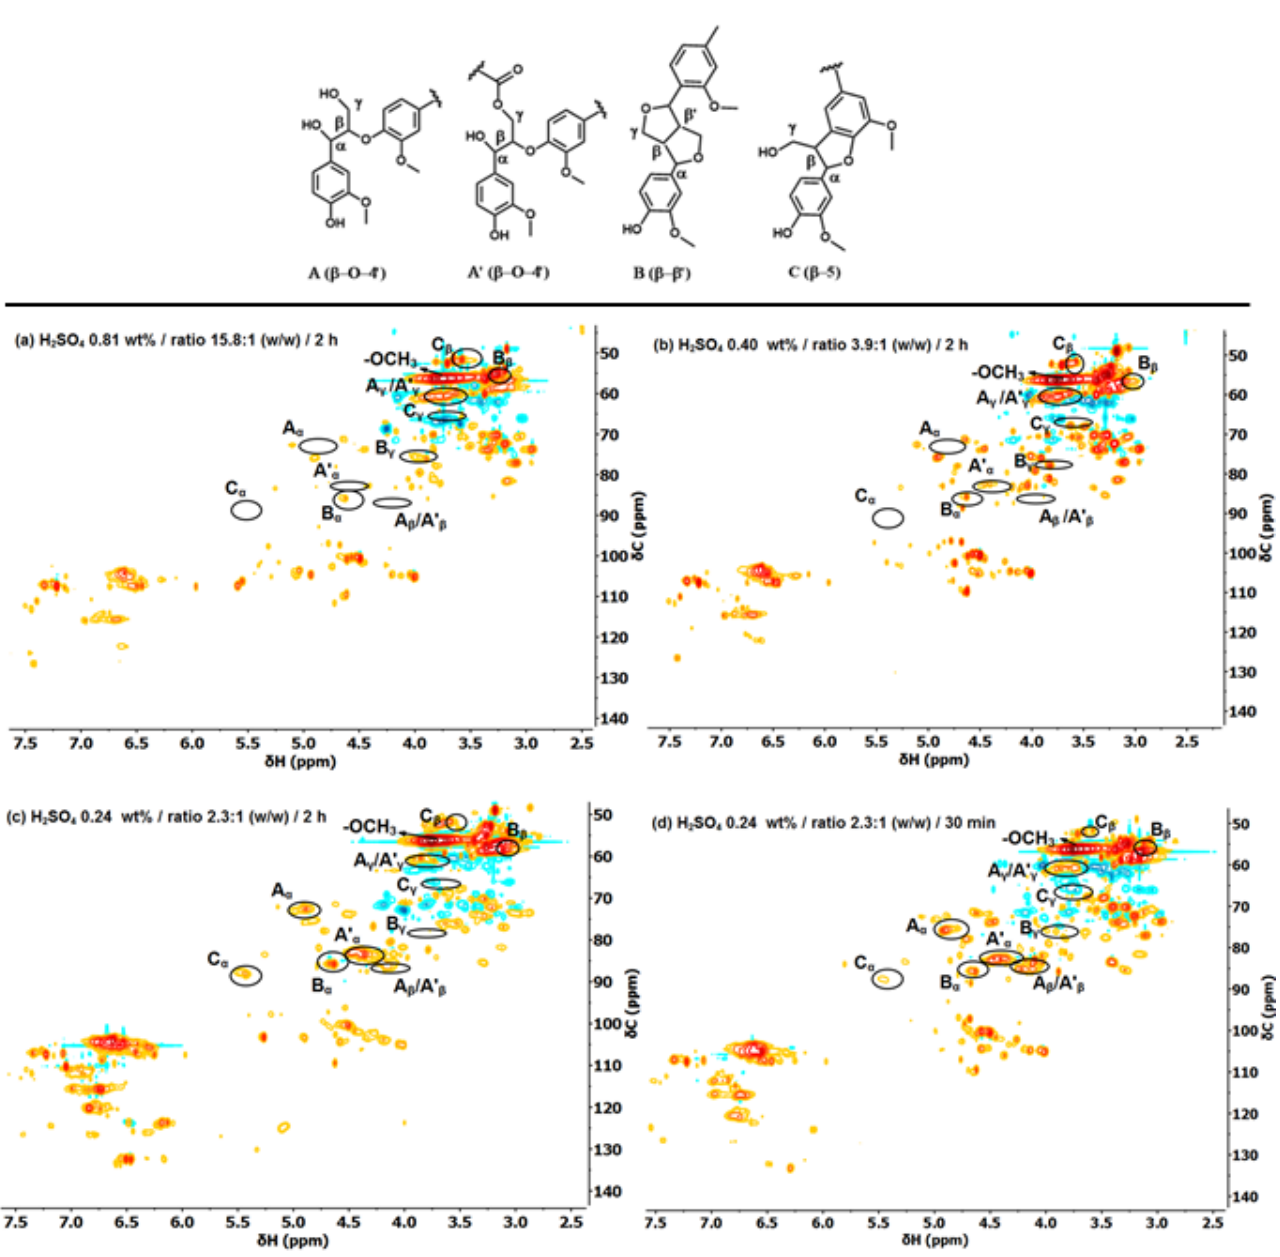
Figure 4. HSQC NMR analysis of lignin oil obtained after acid methanolysis of birchwood at 180 °C ( a ) for 2 h, 0.81 wt% sulfuric acid and ratio of 15.8:1 w / w ; ( b ) for 2 h, 0.40 wt% sulfuric acid and ratio of 3.9:1 w / w ; ( c ) for 2 h, 0.24 wt% sulfuric acid and ratio of 2.3:1 w / w ; ( d ) for 30 min, 0.24 wt% sulfuric acid and ratio of 2.3:1 w / w .